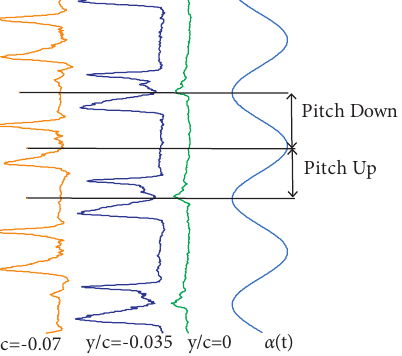
Figure 17. Instantaneous voltages of three sensors, pitch oscillation α (t) = 3 + 3 sin (2πt/T – π/2), frequency = 3Hz, Mach = 0.4.